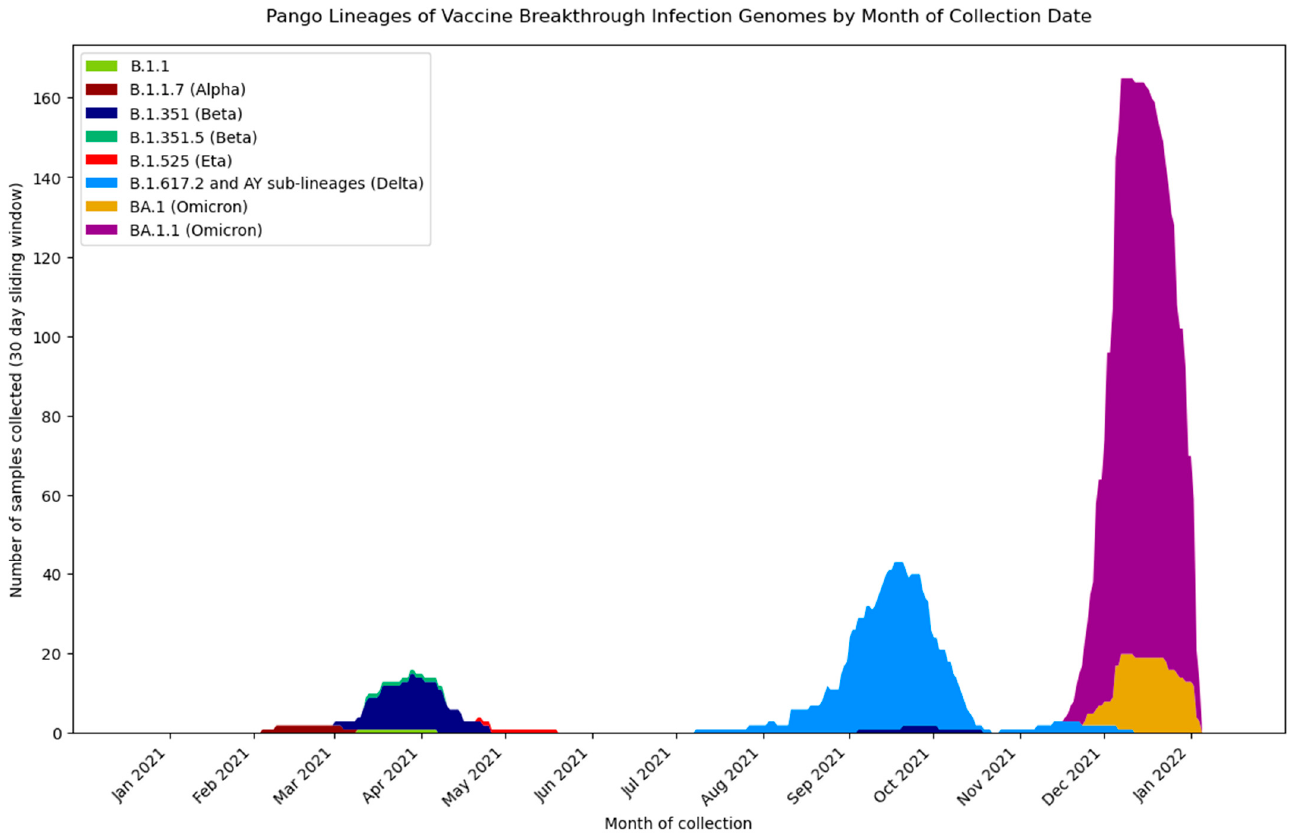
Figure 3. Pango lineage distributions over time of vaccine breakthrough infection genomes, excluding genomes < 20,000 nt.